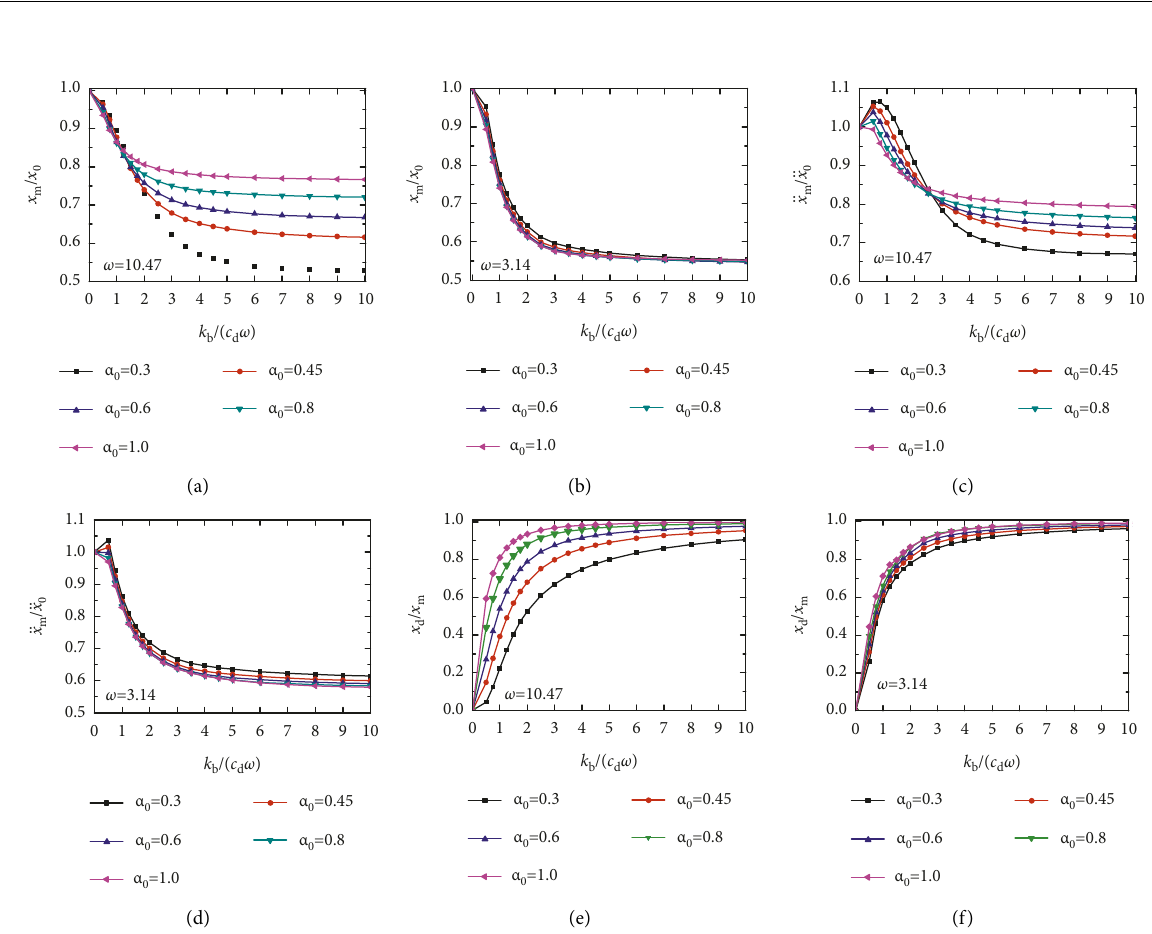
Figure 3: Influence of the parameters k 2.0s, respectively: (a)-(b) the displacement ratios of ETD to UST; (c)-(d) the acceleration ratios of ETD to UST; (e)-(f) the displacement ratios of VD to